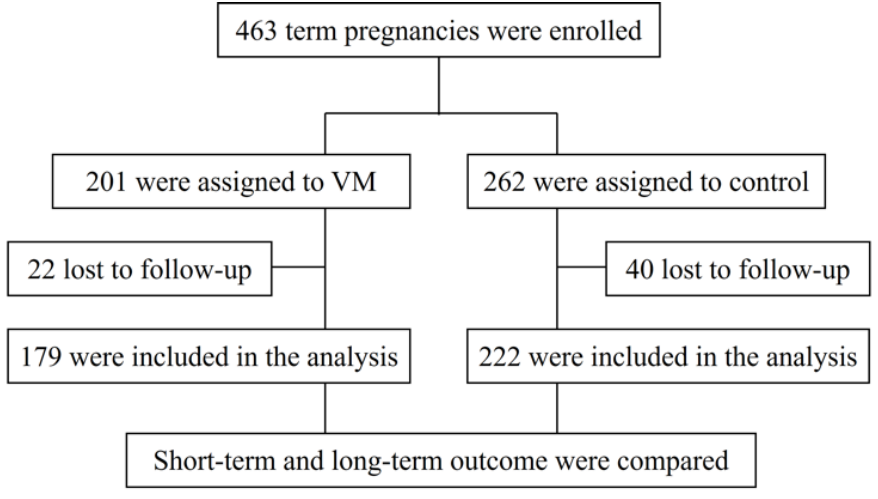
Figure 2. Profile of the cohort study. The short-term outcomes of infants were measured primarily using Apgar scores and the NICU admission during the perinatal period while long-term outcome was assessed as any clinical manifestations of abnormal neurodevelopment occurring after 1 year of